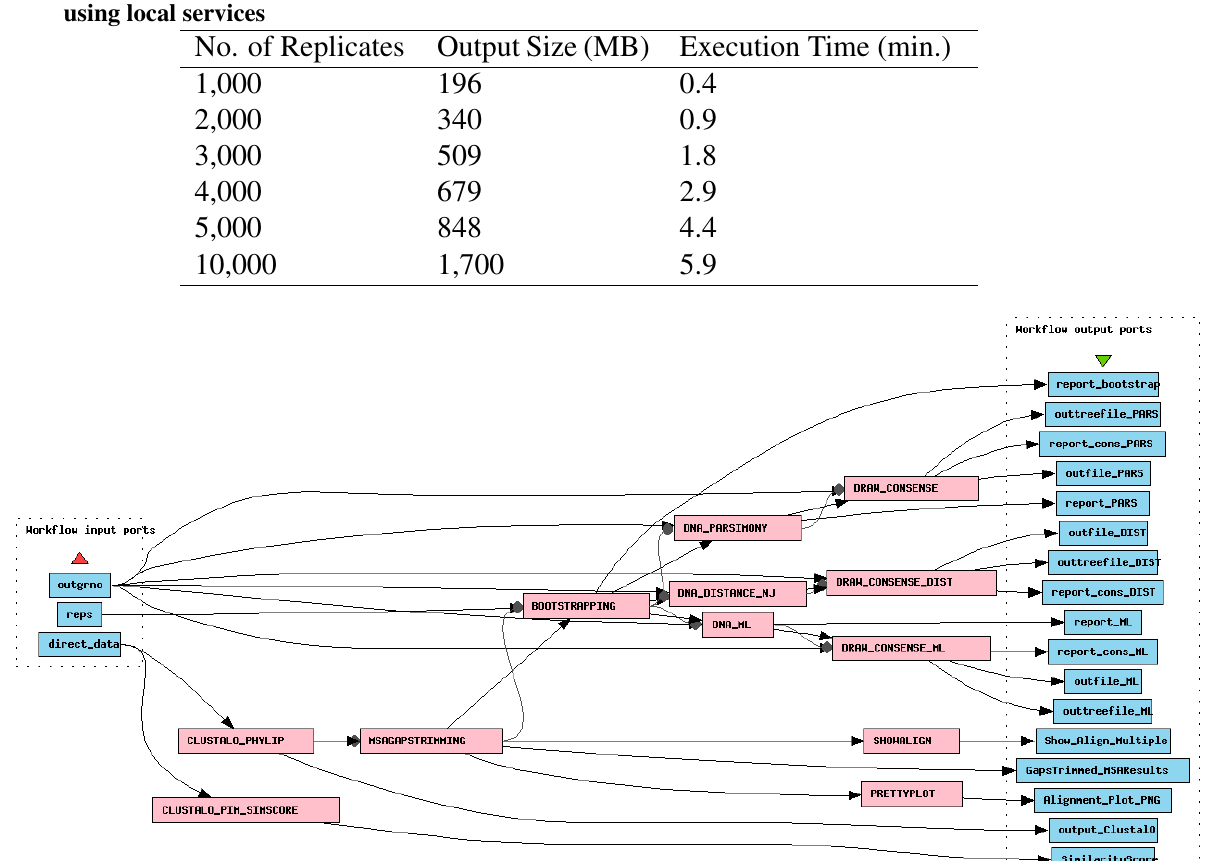
Figure 5: The integrated workflow of tree inferring algorithms using local and helper services in a collapsed display